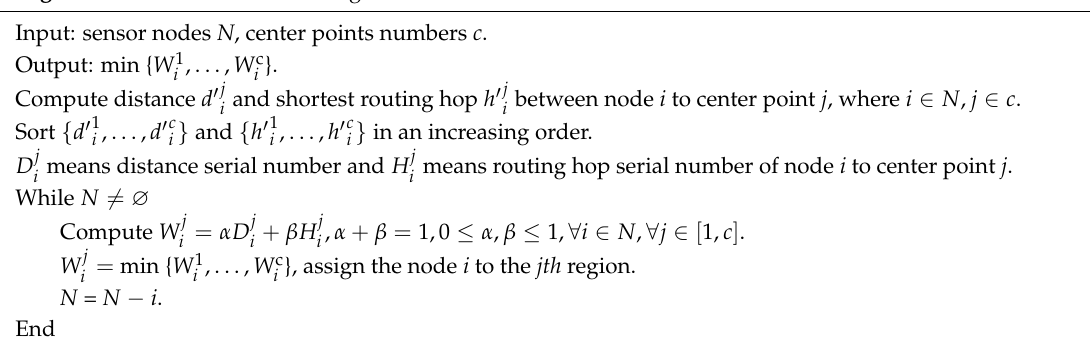
Algorithm 1 A Twice-Partition Algorithm Based on Center